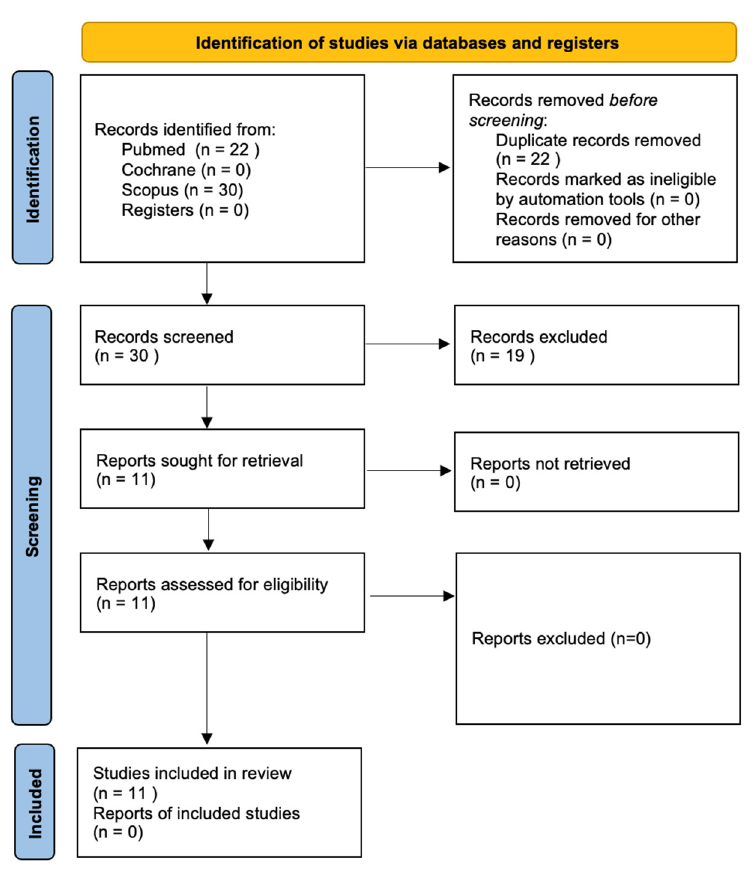
Figure 1. PRISMA Flow Diagram.